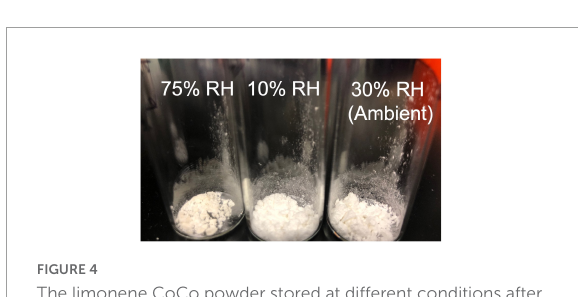
FIGURE4 The limonene CoCo powder stored at different conditions after 1